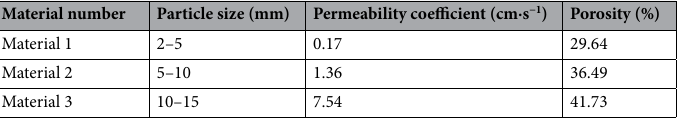
Table 1. Relevant parameters of gravel with different particle